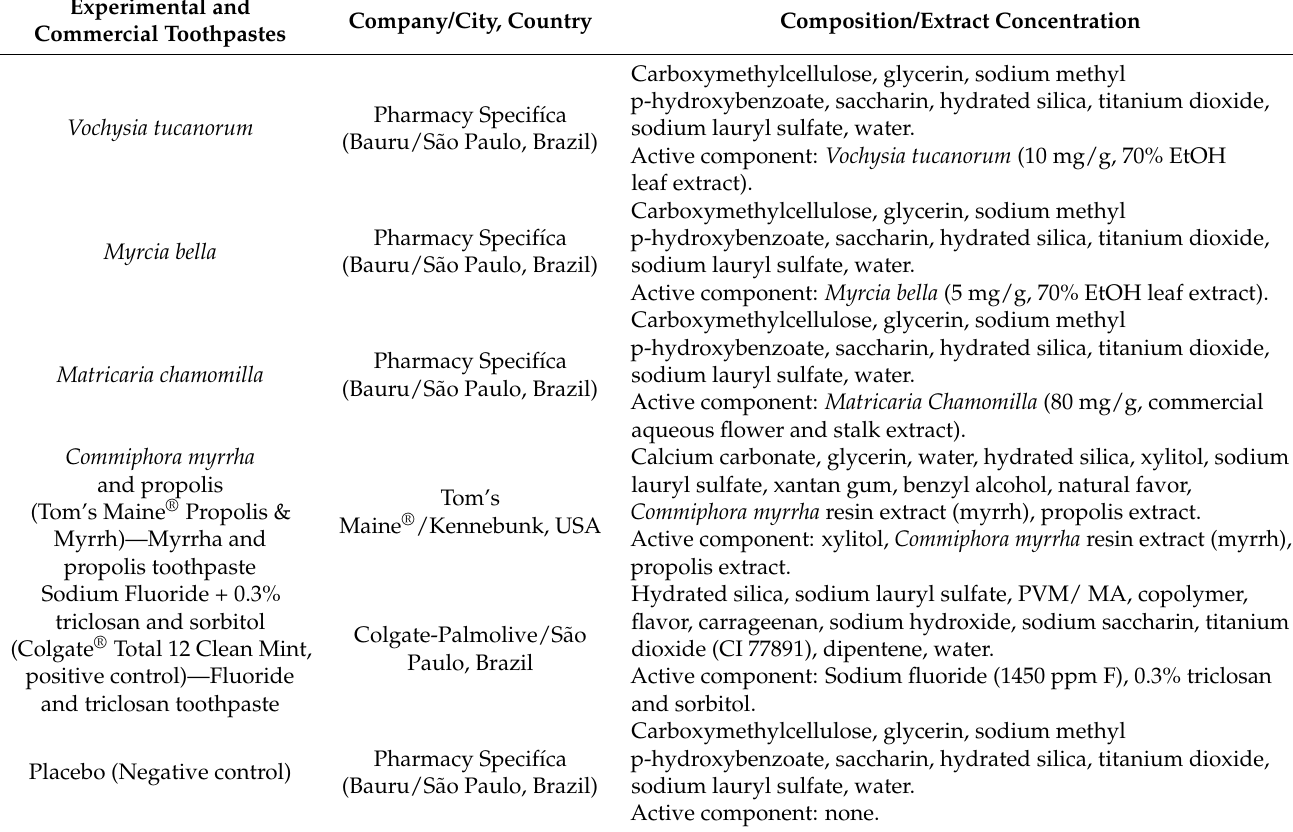
Table 1. Experimental and commercial